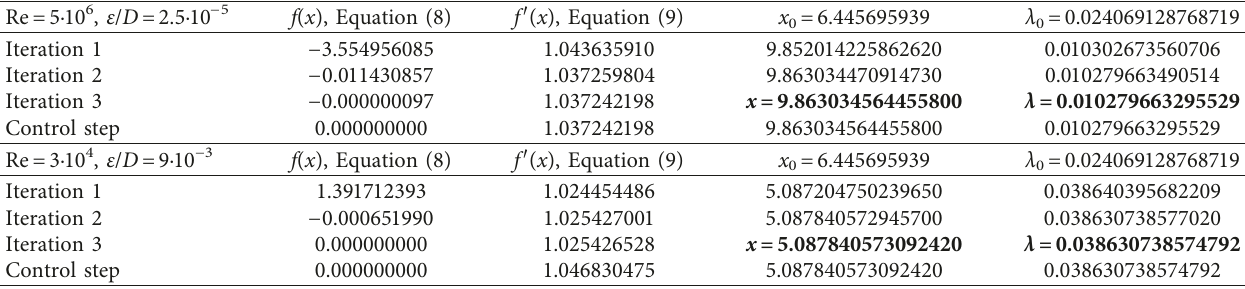
Table 3: Newton–Raphson procedure. Option 3: fixed initial starting point x indirect calculation of λ through the transmission factor x : Equation (10), and analytical derivative f ′ ( x ): Equation